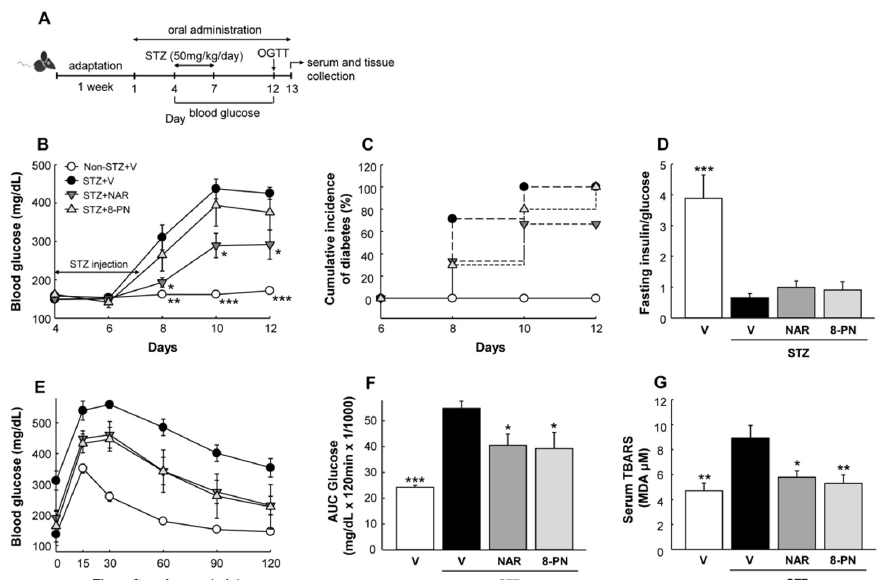
Figure 1. Effects of naringenin and 8-PN on glucose homeostasis. ( A ) Timeline of the study. On the 4th day of oral administration, diabetes was induced by intraperitoneal injection of STZ at a dose of 50 mg/kg/day for four consecutive days. ( B ) Random-fed blood glucose concentrations. ( C ) Cumulative incidence of diabetes was calculated as the percentage of hyperglycemic mice (glucose level ≥ 250 mg/dL) at each time point. ( D ) The ratio of fasting serum insulin (pg/mL) to blood glucose (mg/dL) was used as an index of insulin deficiency in mi € ( E ) Glucose concentrations during glucose tolerance testing with ( F ) corresponding area under the curve (AUC) ( × 1/1000) were measured at Day 12. ( G ) Thiobarbituric acid reactive substances (TBARS) concentrations in serum were expressed in terms of malondialdehyde (MDA) equivalents. V, vehicle; NAR, naringenin; 8-PN, 8-prenylnaringenin. Data are shown as means ± SEM (n = 6). * p < 0.05, ** p < 0.01, *** p < 0.001 vs. STZ-vehicle group.